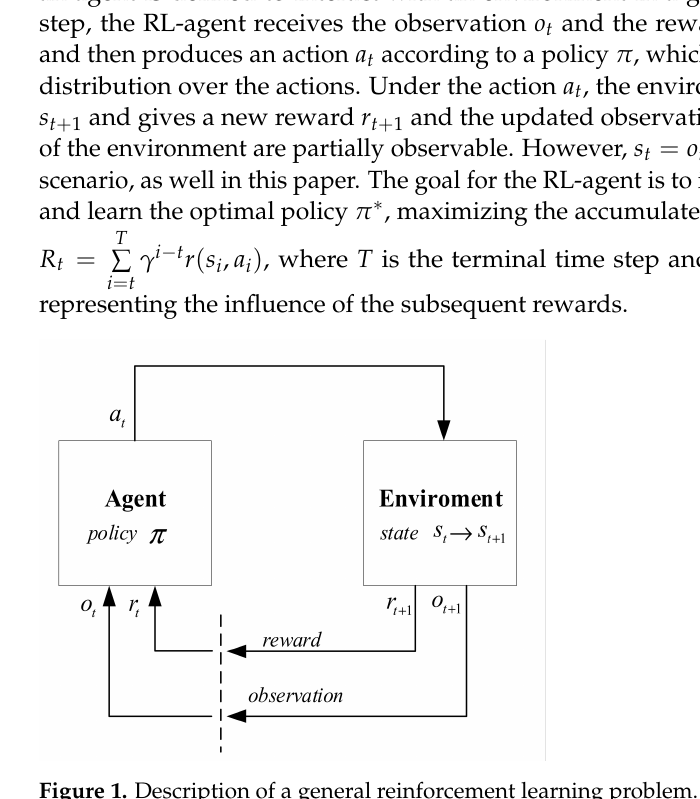
Figure 1. Description of a general reinforcement learning